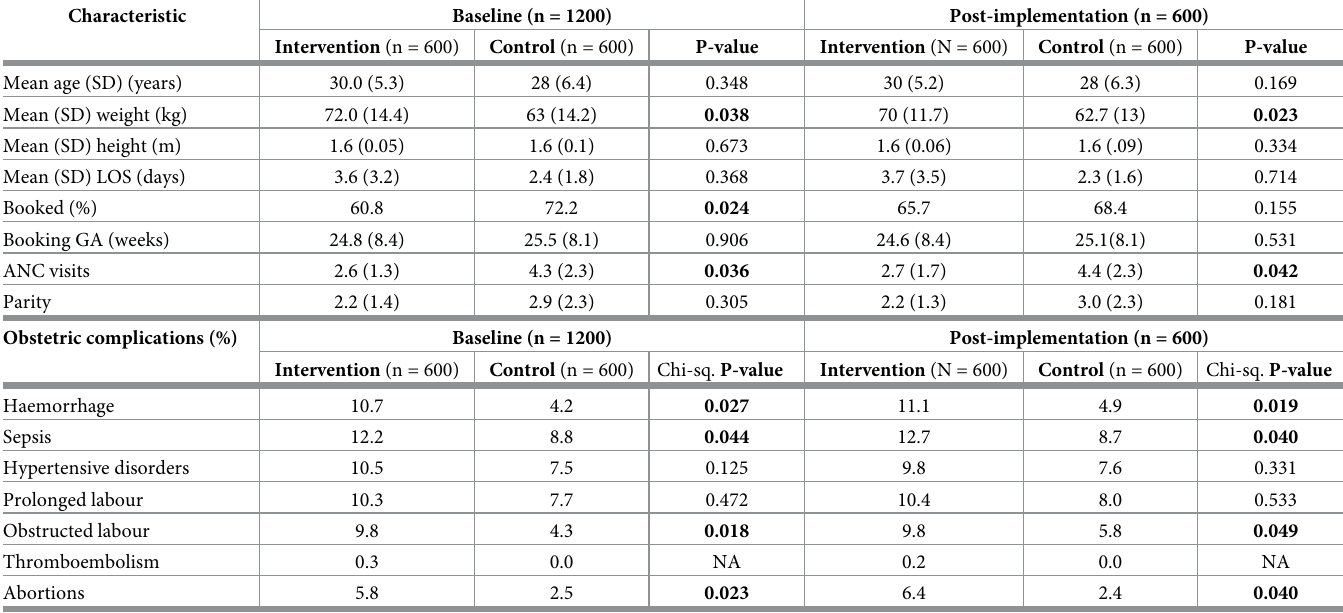
Table 1. Characteristics of study